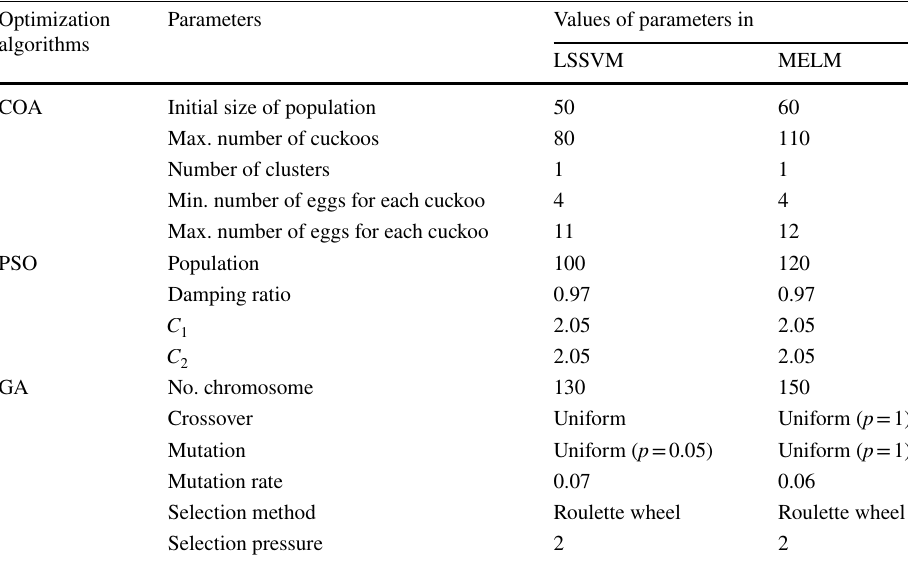
Table 5 Determined values of adjustable parameters of the optimizer algorithms for modeling the permeability following a trial-and-error